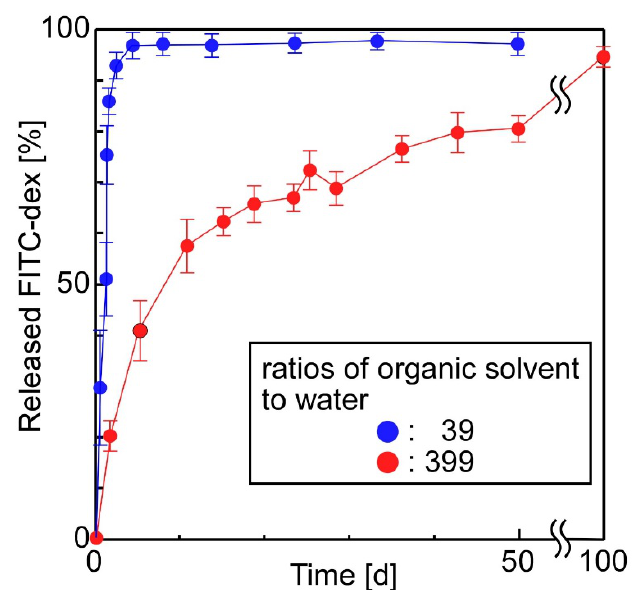
Figure 6. The effect of the ratio of organic solvent to water in the preparation stage of emulsions on the release properties of the sheets (the sheet-forming polymers were PLA (2 w/v%) + PLGA (2 w/v%); number of layers: 11).